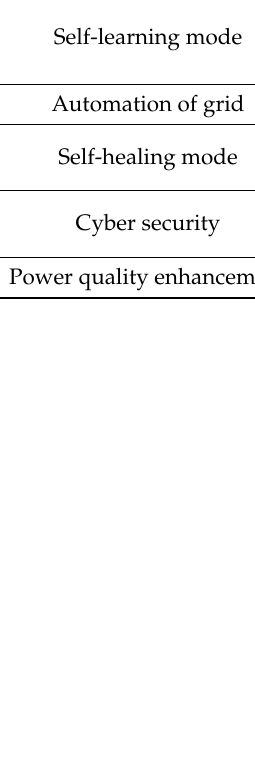
Table 7. Future developments in smart grids—leveraging data science and statistical tools. Future Developments Role Expected—Data Science, AI and Statistical Tools Self-learning